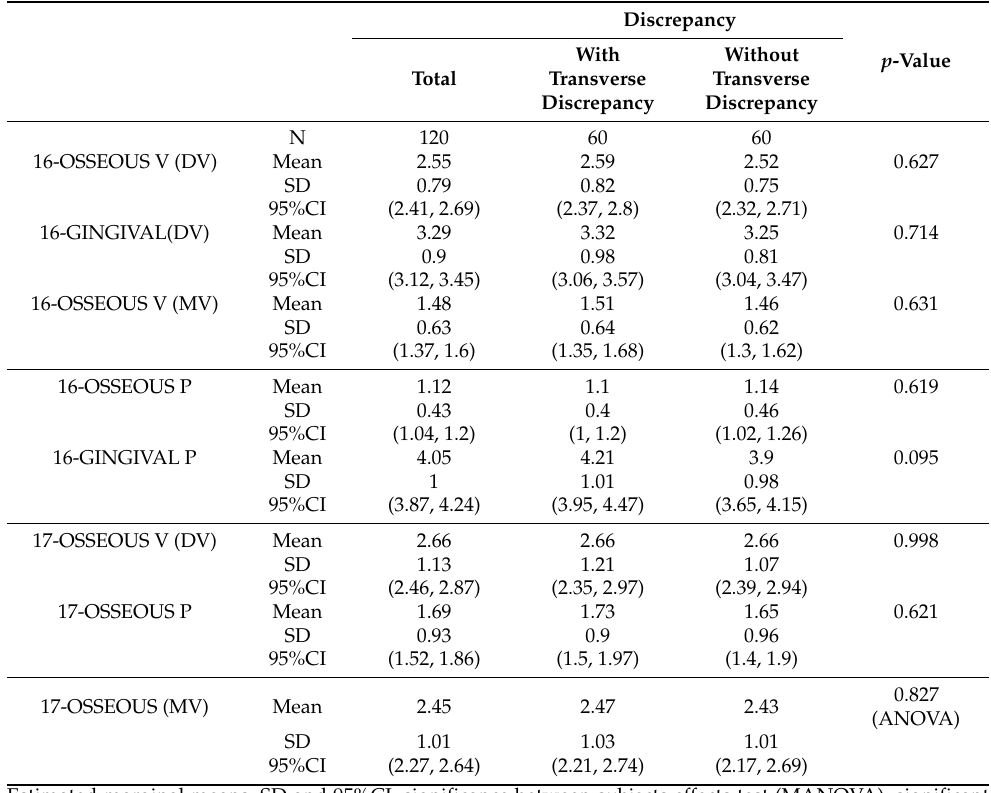
Table 4. Linear measurements corresponding to upper right molars in the presence and absence of transverse bone